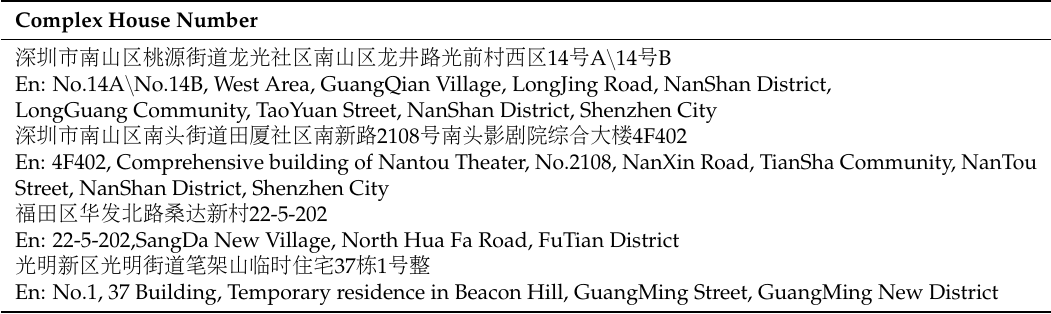
Table 3. Examples of complex house numbers.